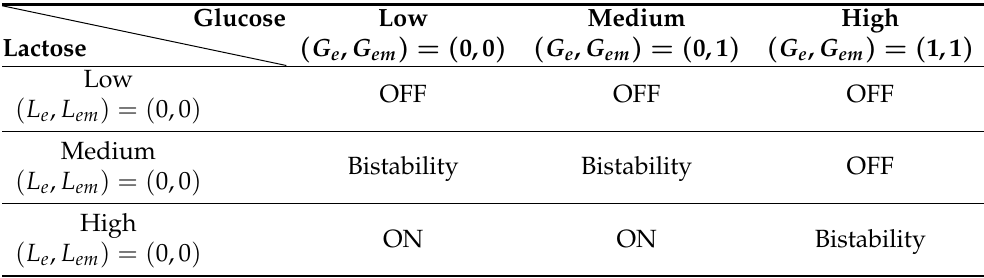
Figure 14. Interaction digraph of the improved original model with additional parameter G em and the local functions of Figure 13. Table 7. The possible cases in the 4-parameter model of Figures 13 and 14 for each of the nine combinations of